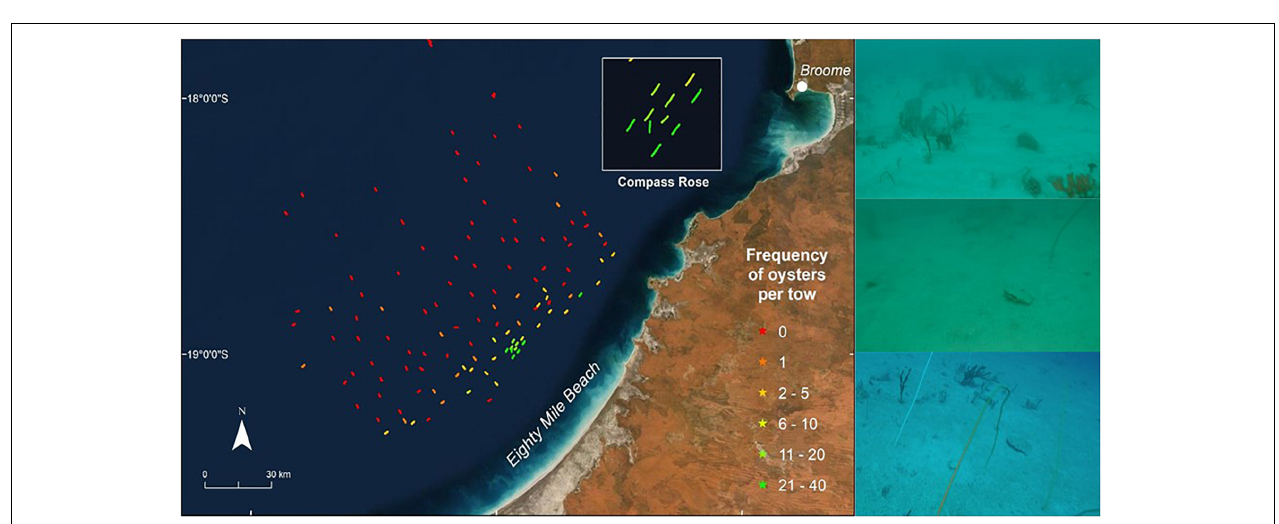
FIGURE 3 | Analysis steps undertaken to: (A) predict the probability of habitat class “sparse filter feeders” which, in our data set, most frequently coincided with the presence of oysters, and (B) predict the presence versus absence of oysters incorporating predictions of sparse filter feeders from the first model. Thus, step 6 from model (A) produces the “Existence probability class map” which feeds into step 2 of model (B) as shown in the figure.